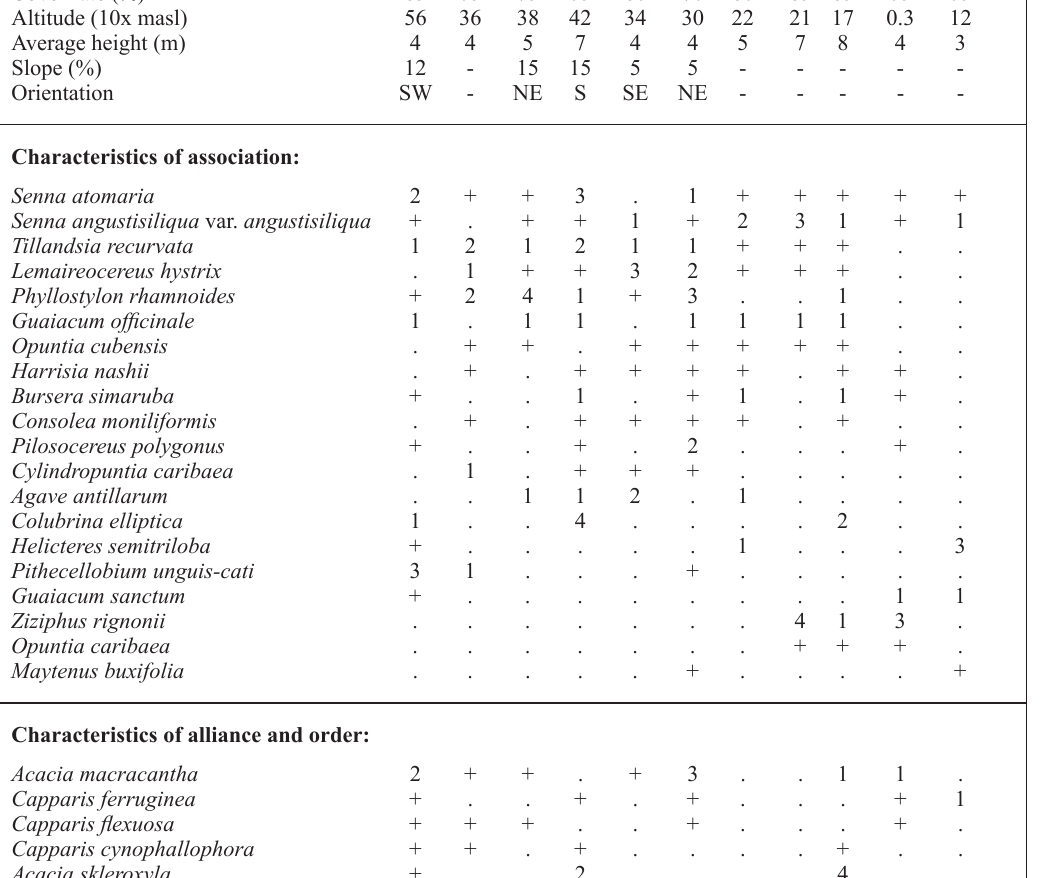
Acacia macracantha 2 +